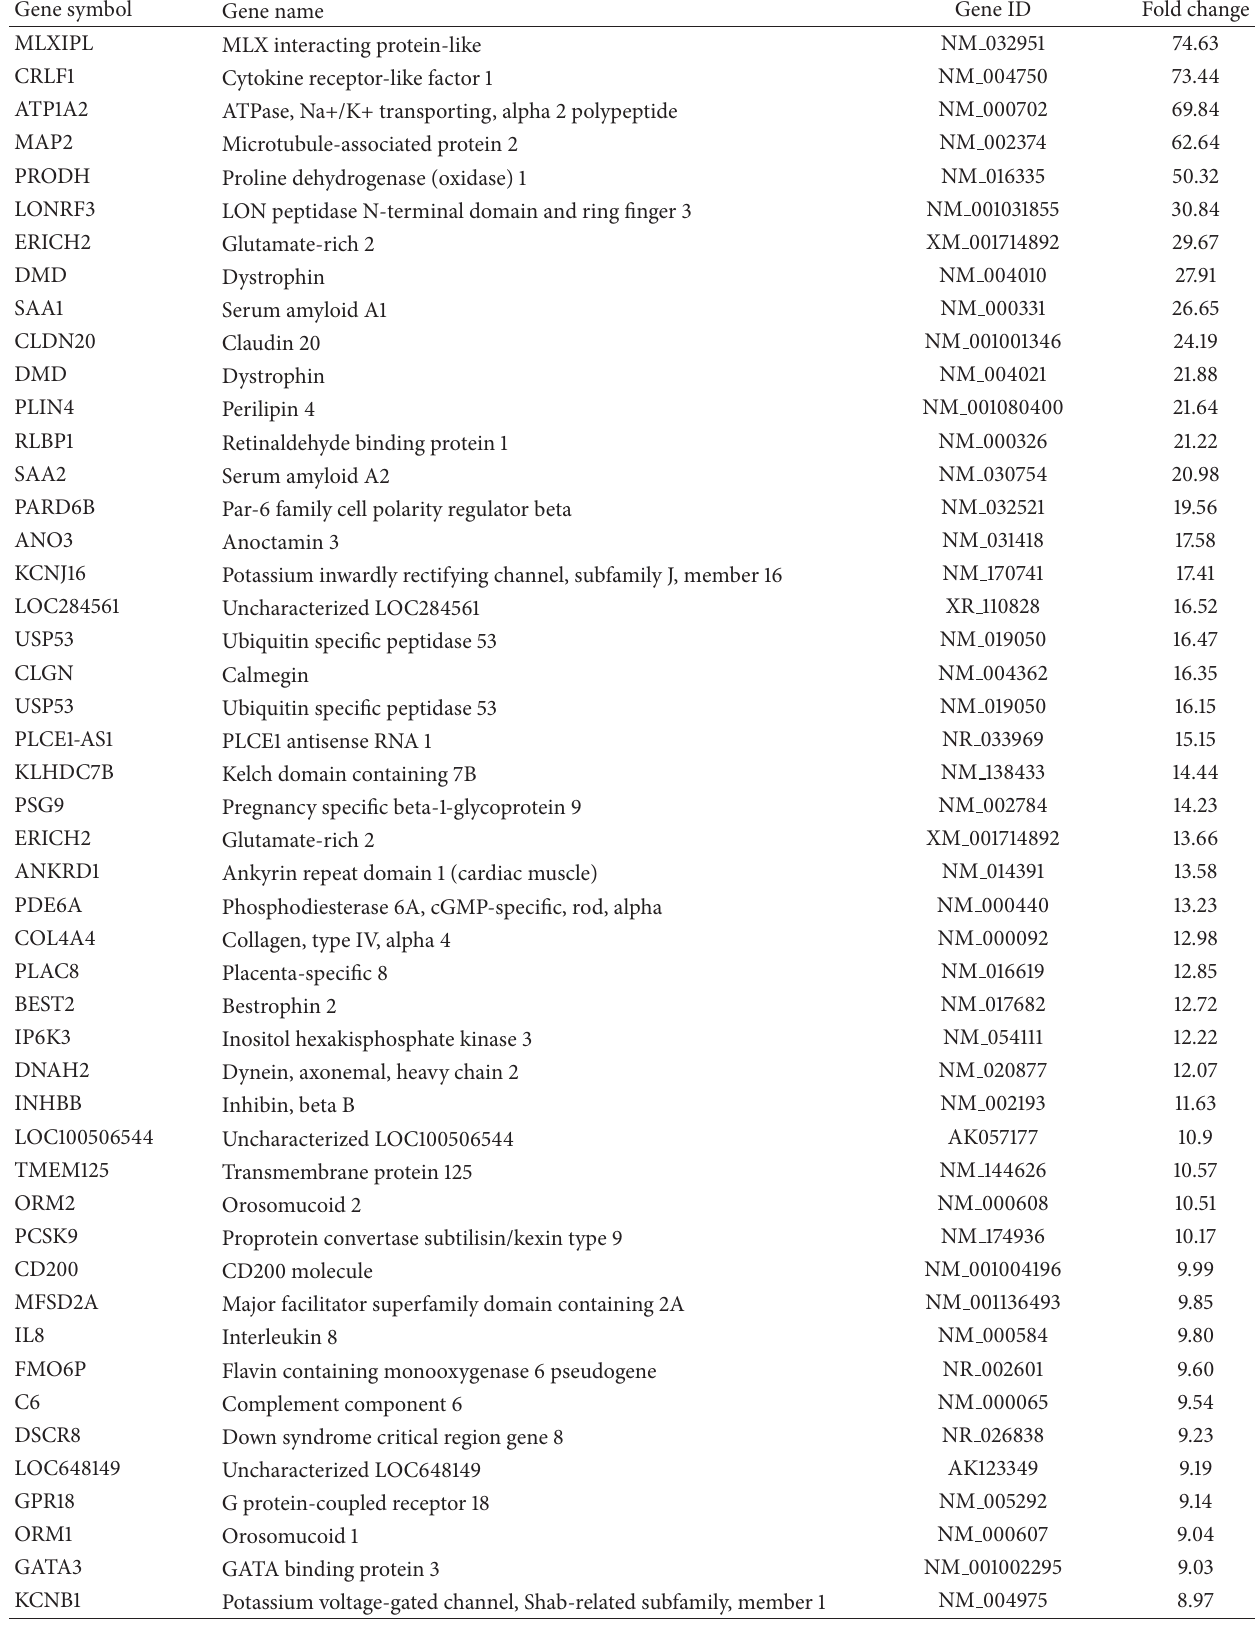
Table 3: The list of upregulated genes in MSX1-knockdown cells (top